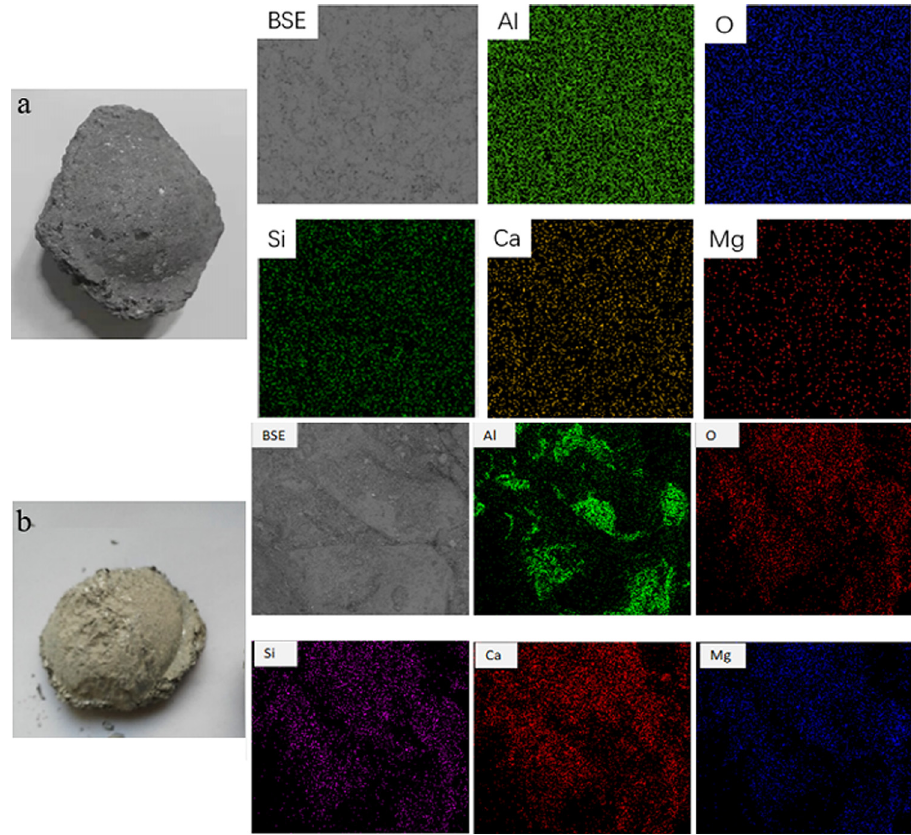
Figure 1: Digital photos and surface scanning of the two modi fi ers: ( a ) original modi fi er and ( b ) new modi fi